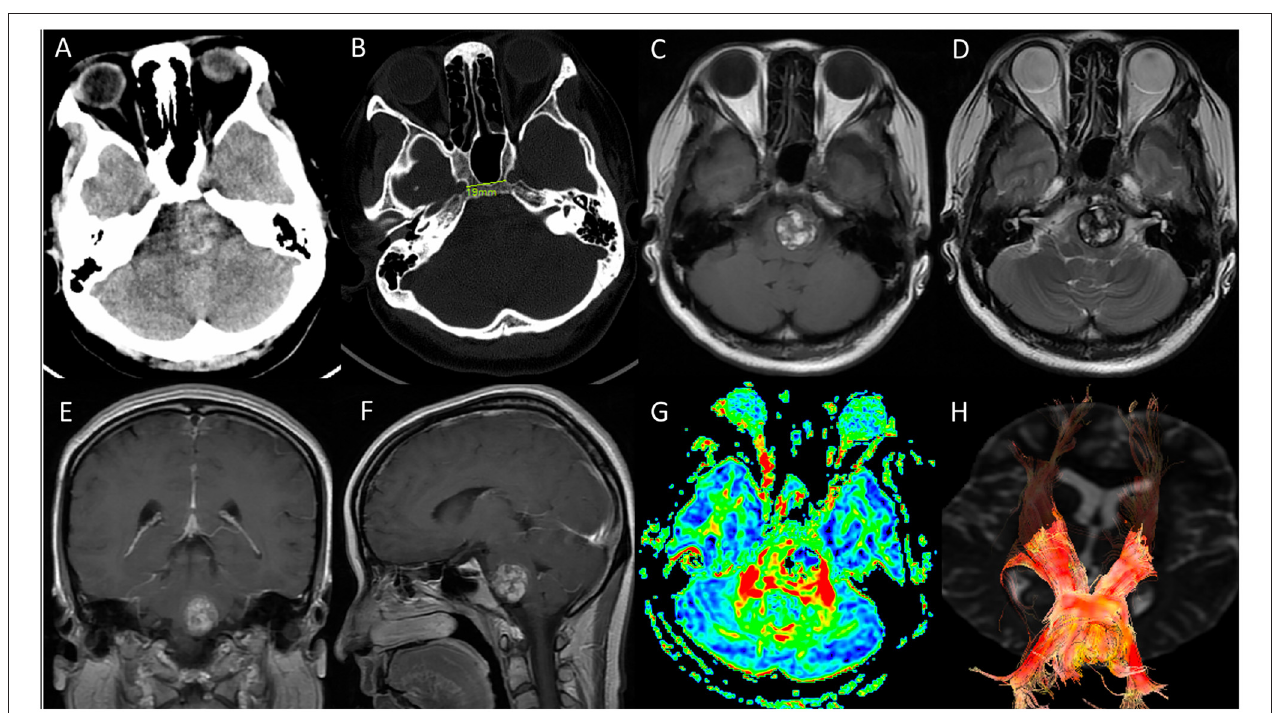
FIGURE 1 | Preoperative imaging. (A,B) CT scan revealed a hemorrhagic occupying lesion in the left pons with acute blood products and indicated a distance of 19mm between para clival carotid in bone window. The development and the degree of pneumatization of sphenoid sinus was suitable for endoscopic endonasal surgery; (C–F) Axial T1-weighted, T2-weighted, coronal and sagittal T1 postcontrast magnetic resonance image demonstrated a 2.3*2cm ventral pontine CM with hemosiderin surrounded, and no significant enhancement of the CM was observed; (G,H) diffusion tensor imaging (DTI) showed the corticospinal tract was displaced laterally by the